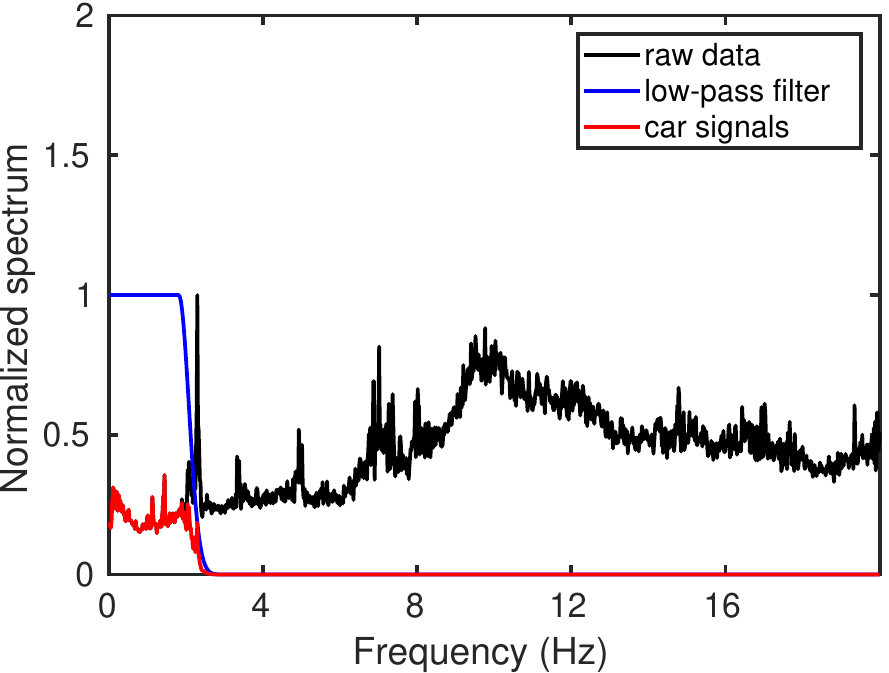
Figure 5. A diagram showing the frequency content of the urban DAS data and low-pass filtering process for car signal isolation. The black line indicates the amplitude spectrum of raw data. The blue line shows the transfer function of the low-pass filter. The red line shows the amplitude spectrum of filtered data that mostly contain car